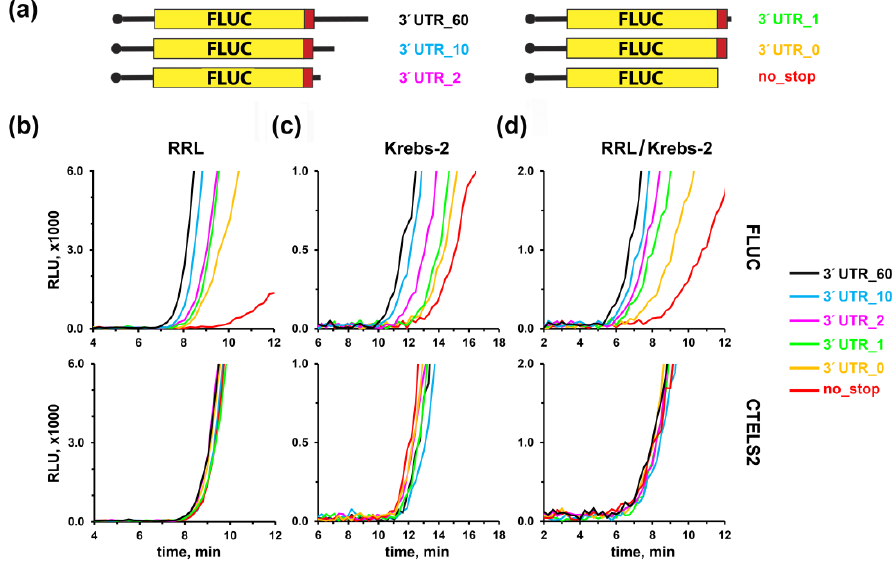
Figure 3. Effects of shortening the 3 ′ UTR on translation termination, as revealed by the CTELS approach. ( a ) A set of capped non-polyadenylated FLUC mRNA constructs used in the experiment. The same set of CTELS2 transcripts is not shown. ( b – d ) Luciferase activity produced by translation of the FLUC and CTELS2 mRNAs in three different cell-free systems: RRL ( b ), Krebs-2 S30 extract ( c ), and the hybrid RRL/Krebs-2 system ( d ). Representative curves of at least three independent experiments are shown.